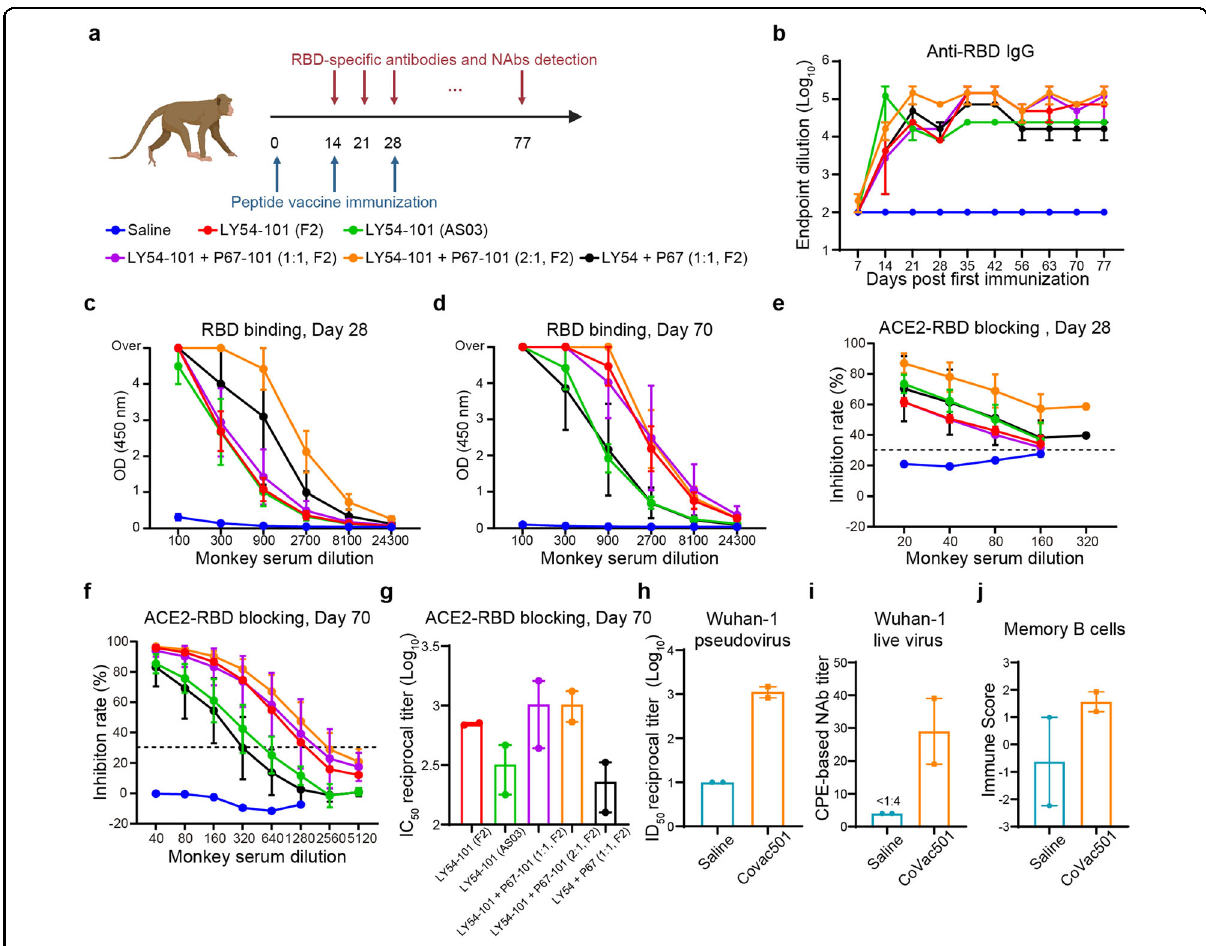
Fig. 4 CoVac501 induced protective humoral immune responses in cynomolgus macaques. a Schematic diagram of immunization, sample collection, and detection in cynomolgus monkeys. Cynomolgus monkeys ( n = 2) were immunized with peptide vaccines in the following groups: saline, LY54 – 101 (F2), LY54 – 101 (AS03), LY54 – 101 + P67 – 101 (1:1, F2), LY54 – 101 + P67 – 101 (2:1, F2), and LY54 + P67 (1:1, F2) for three doses at days 0, 14, and 28. b – d Sera were collected from the monkeys and the levels of RBD-speci fi c antibody were tested for different serum dilutions using ELISA. e – g Sera were collected from monkeys 28 ( e ) and 70 ( f , g ) days after the fi rst dose of vaccine and ACE2-RBD blocking antibodies were tested for different serum dilutions using ELISA. h The neutralization of sera from cynomolgus monkeys 63 days after the fi rst dose of vaccine for